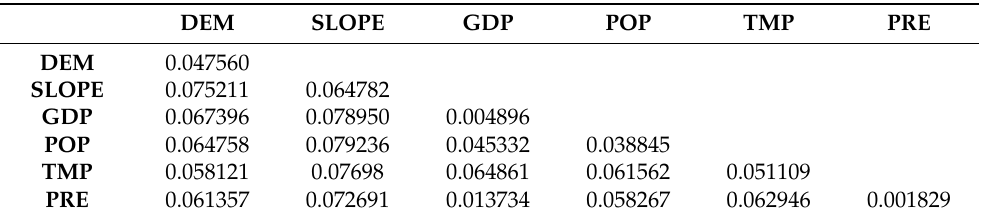
Table A10. The force (q-value) among any two influencing factors on Percentage of Landscape (PLAND) interactively in 2020.